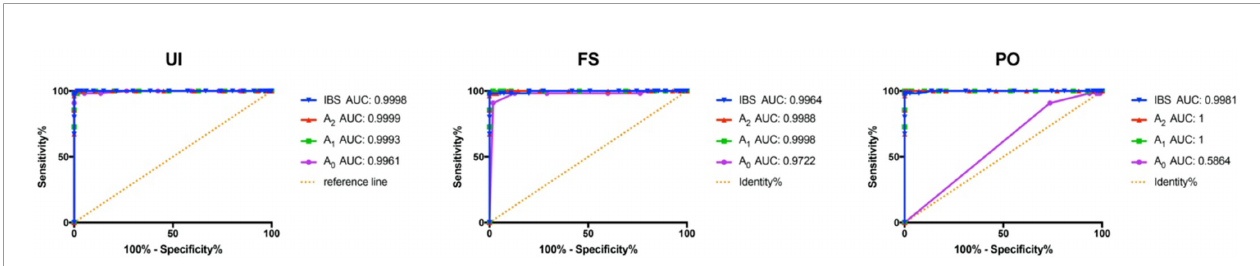
FIGURE 5 | ROC curves of the four values (A 0 , A 1 , A 2 , and IBS score) in UI, FS, and PO. ROC, receiver operating characteristic; IBS, identity by state; UI, unrelated individual; FS, full sibling; PO, parent –